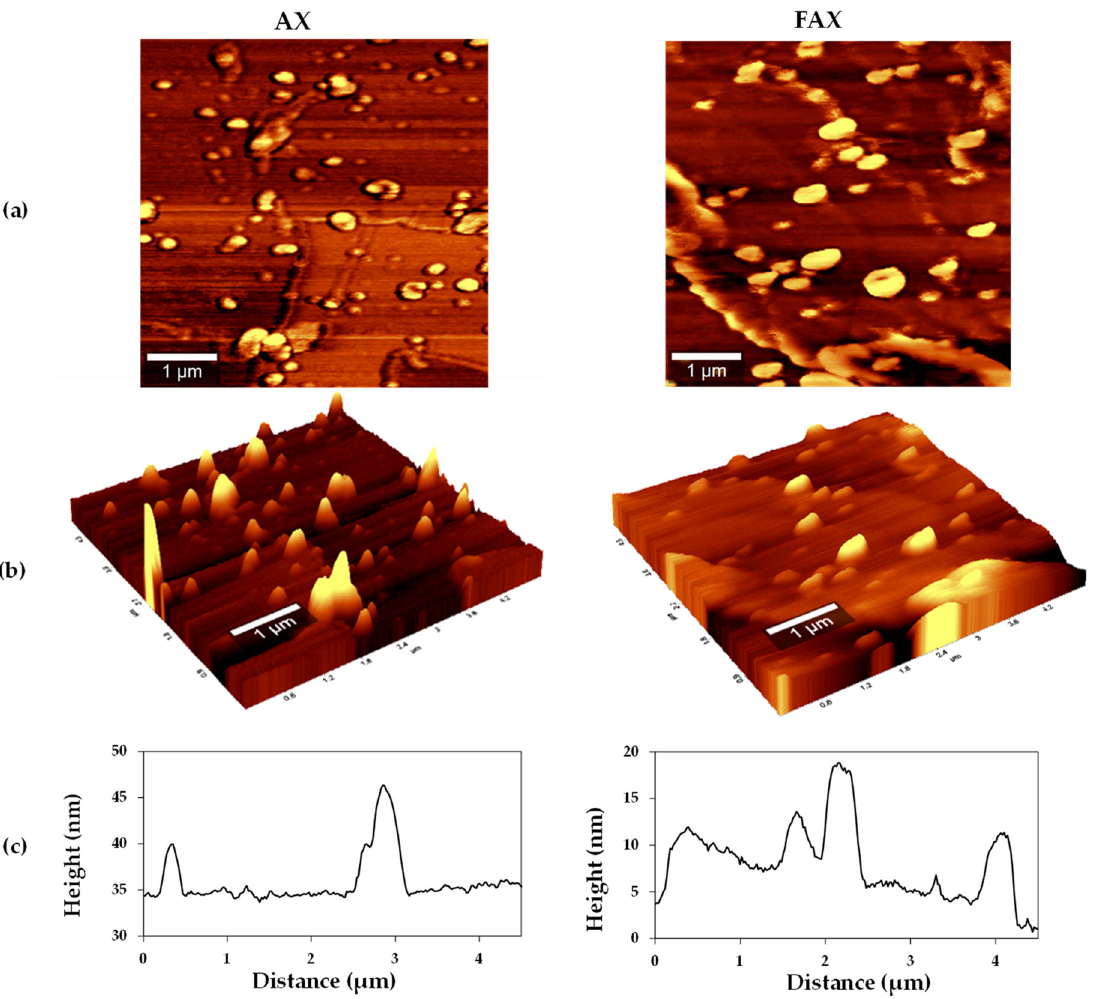
Figure 4. Atomic force microscopy topography analysis of AX (left) and FAX (right) ( a ) 2D surface image ( b ) 3D surface image and ( c ) profile line. Dispersions (5 μ m × 5 μ m).